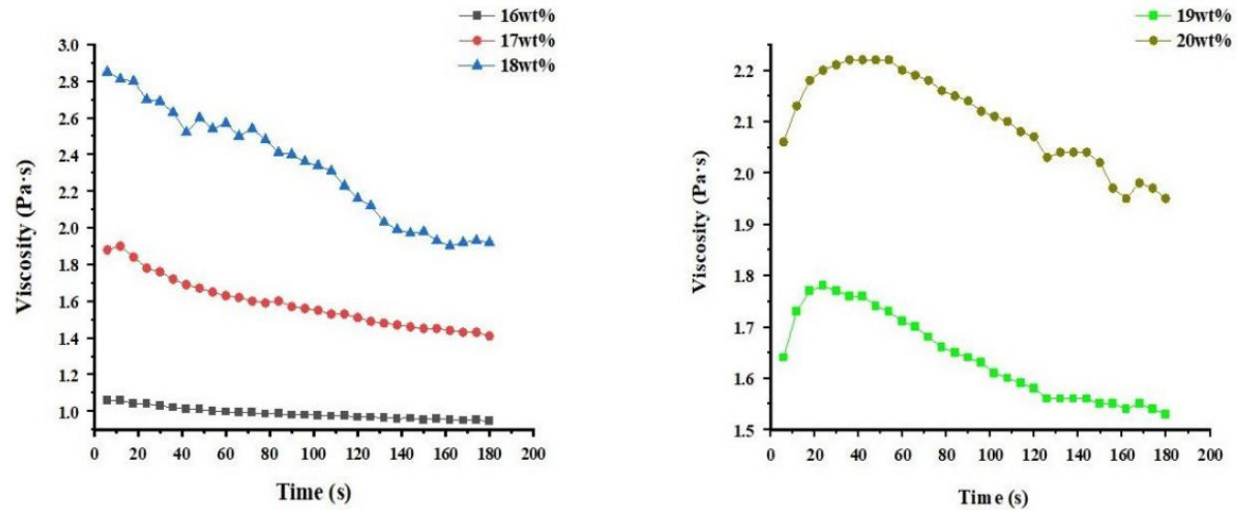
Figure 4. The variation curve of the viscosity of the spinning solution with the concentration.